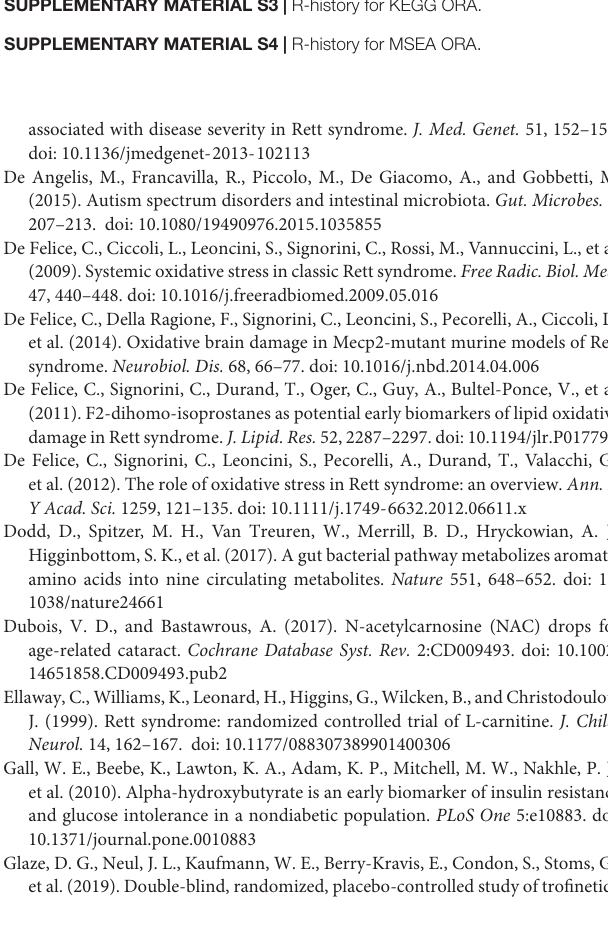
TABLE S1 | Subject characteristics. TABLE S2 | Complete normalized metabolite levels. TABLE S3 | List of t -test results and fold changes for all metabolites. TABLE S4 | Random Forest Features. TABLE S5 | Biomarker ROC results. TABLE S6 | KEGG Over-representation analysis results. TABLE S7 | KEGG analysis name matching. TABLE S8 | MSEA results. TABLE S9 | MSEA name